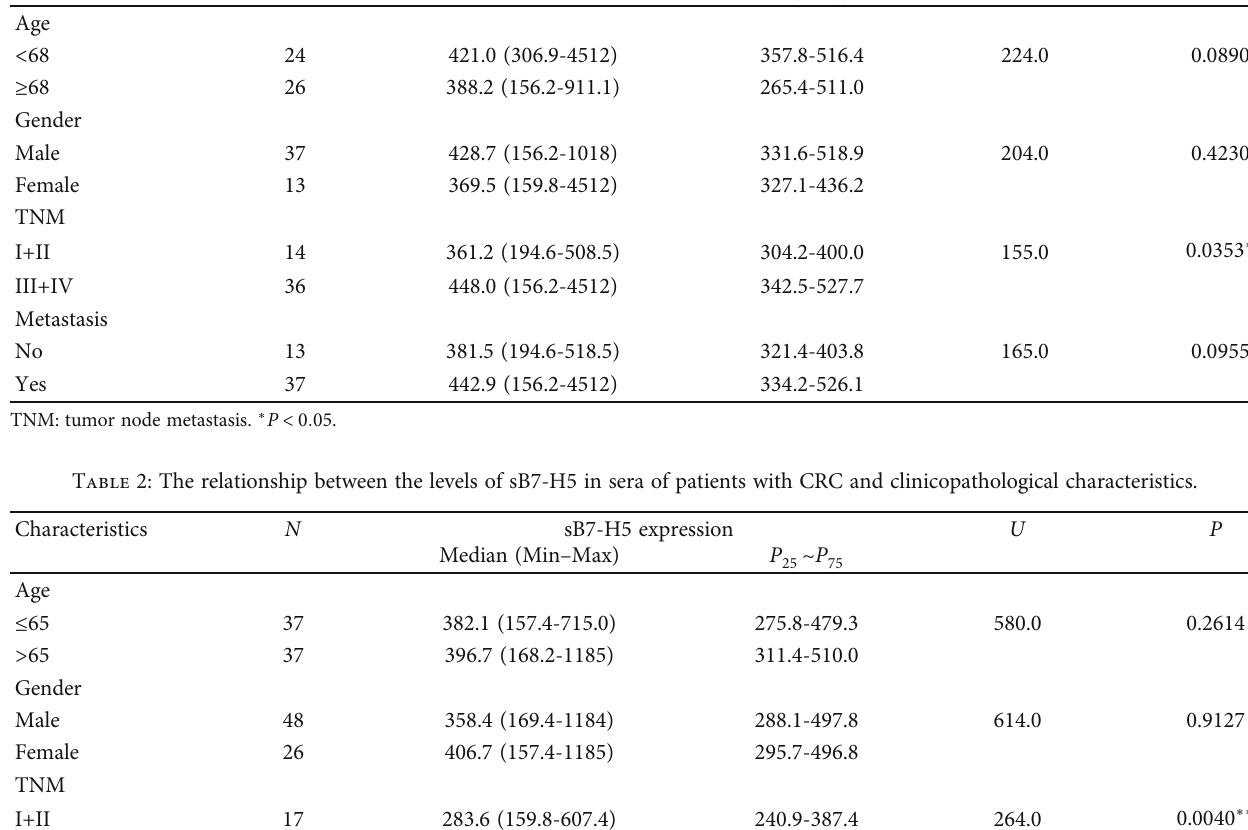
Table 1: The relationship between the levels of sB7-H5 in sera of patients with GC and clinicopathological characteristics. Characteristics